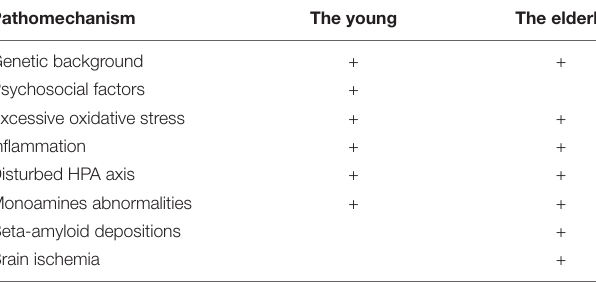
TABLE 1 | Age-dependent mechanisms of cognitive impairment in